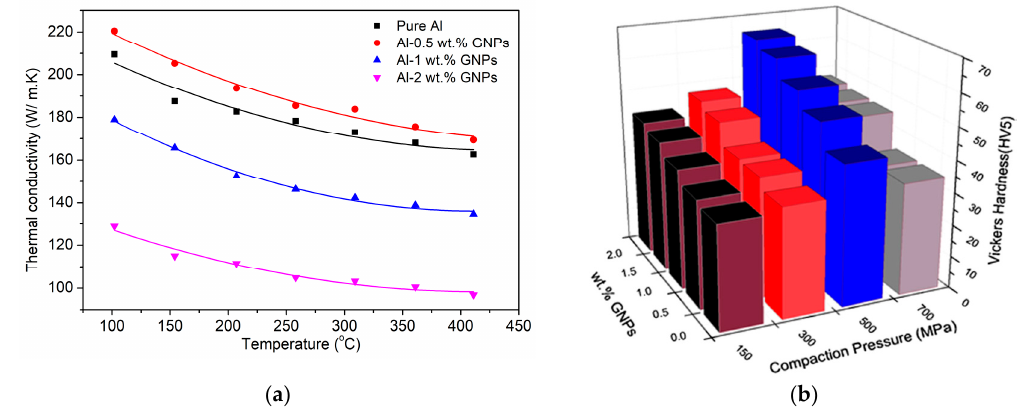
Figure 8. ( a ) Thermal conductivity and ( b ) Vickers hardness of Al/GNPs nanocomposites as a function of GNPs [129], Reproduced from [129], with permission from Springer Nature, 2017.